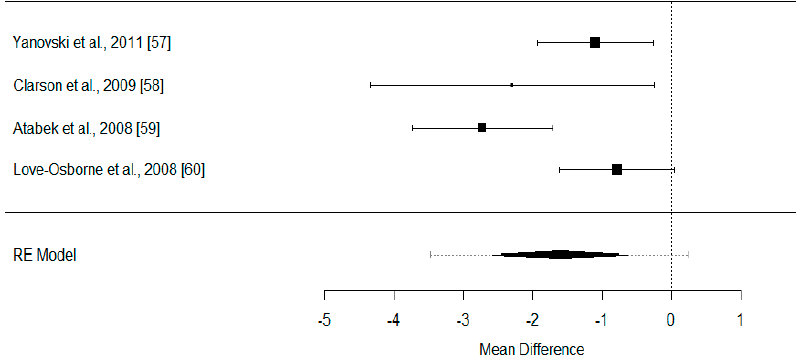
Figure 3. Confidence interval (95%) of the difference in BMI (kg/m 2 ) between intervention groups.